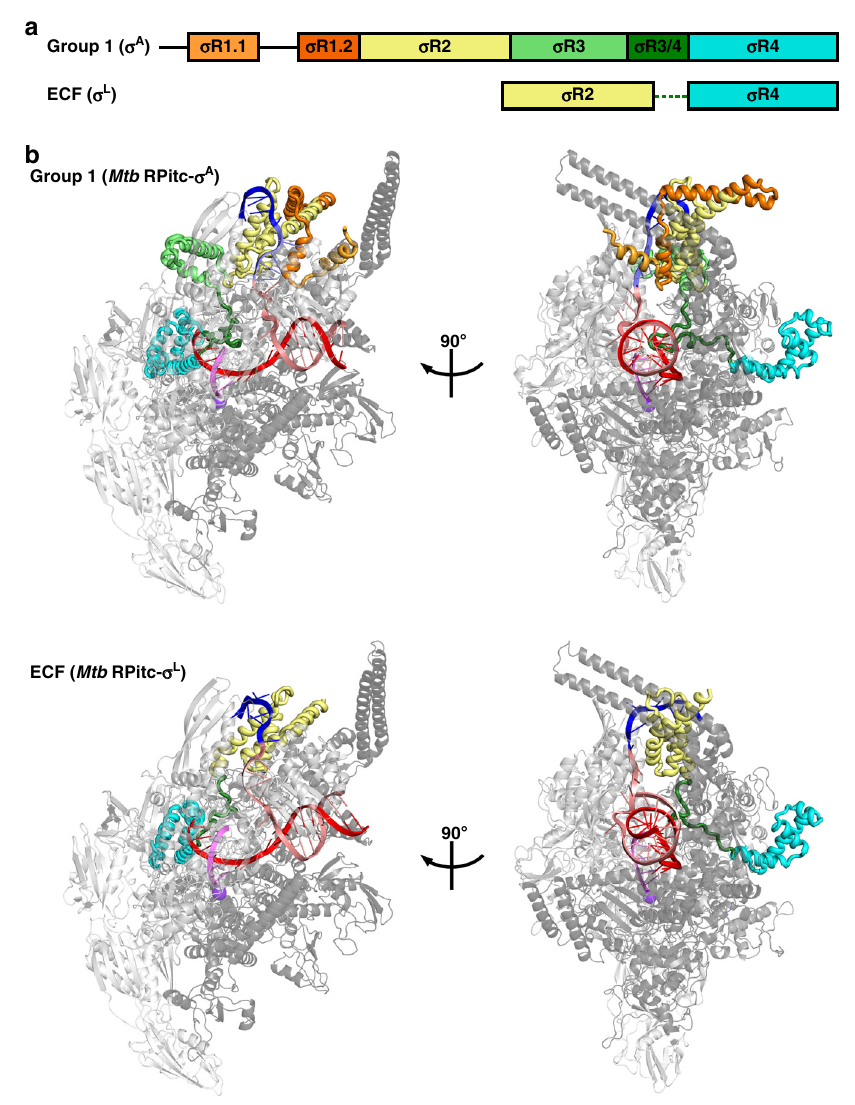
Fig. 1 Structures of group-1 and ECF σ factors. a Structural organization of group-1 ( σ A ) and ECF ( σ L ) σ factors. Conserved regions σ R1.1, σ R1.2, σ R2, σ R3, σ R3/4 linker, and σ R4 are in light orange, dark orange, yellow, green, dark green, and cyan, respectively. Dashed line, non-conserved σ R2/4 linker present in ECF σ factors. b Crystal structures of group-1 ( Mtb RPitc- σ A ; PDB 5UH8) and ECF ( Mtb RPitc- σ L ; PDB 6DVC) transcription initiation complexes (two orthogonal views of each). σ factors are shown in tube representations with conserved regions colored as in ( a ). Gray ribbon, RNAP core enzyme; blue, pink, red, and magenta ribbons, -10 element of DNA nontemplate strand, rest of DNA nontemplate strand, DNA template strand, and RNA product; violet sphere, RNAP active-center Mg 2 + . Other colors are as in ( a ). See Supplementary Figs. 1, 2, and